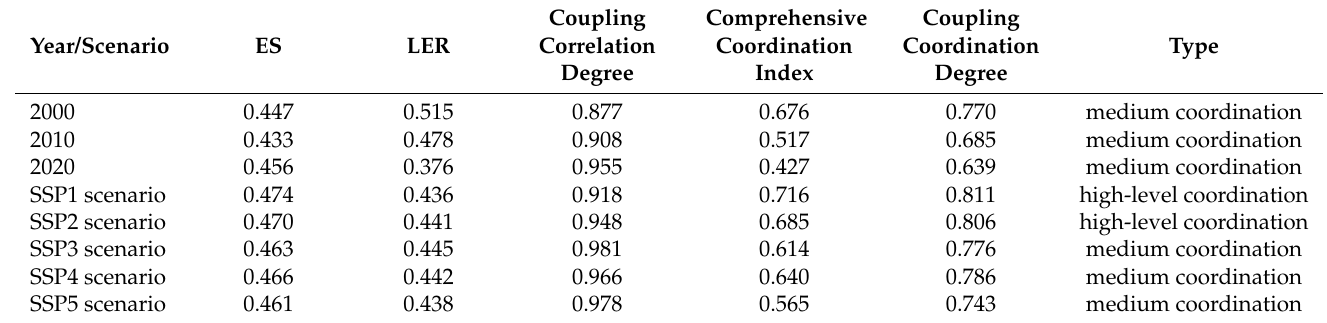
Table 1. Coupling coordination degree of landscape ecological risk and ecosystem